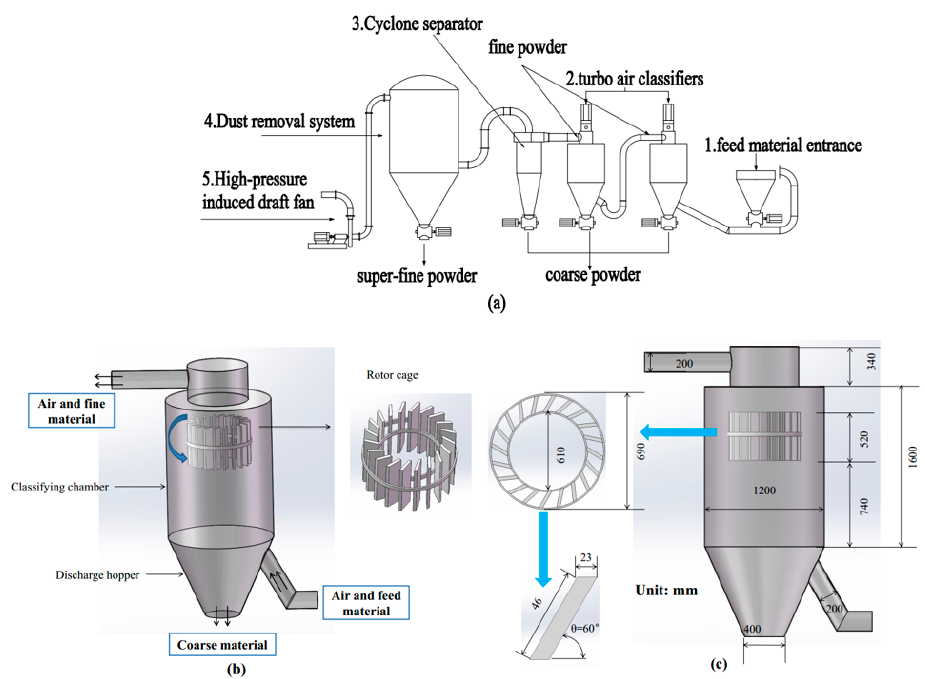
Figure 1. Diagram of the experiment equipment ( a ) and the 3D view of the geometry ( b ) and dimensions ( c ) of the turbo air classifier.